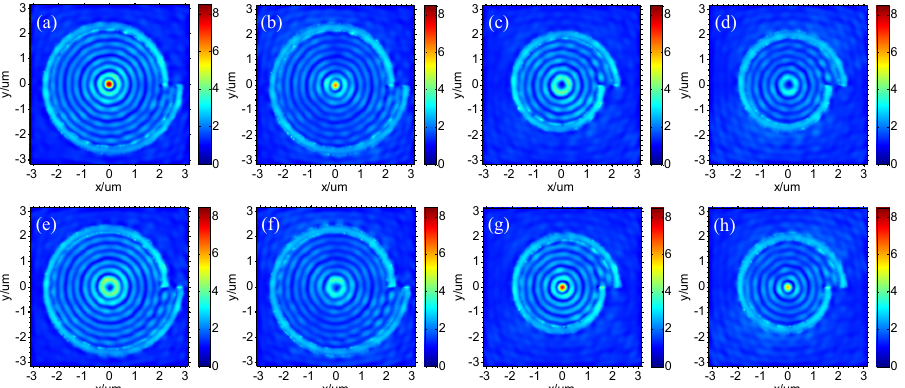
Figure 3. The electric field distribution |E| on the top surface of the plasmonic lens with different structures, illuminated by a circularly polarized beam ( λ = 633 nm ) with normal incidence from the top of the silver film, w 1 = 310 nm, w 2 = 155 nm, h 1 = 110 nm, h 2 = 45 nm, r 0 = 2000 nm. ( a ) |E| distribution when the spiraling of the slot parameter m = 1, with an auxiliary spiral slot and illuminated by a left-circularly polarized light. ( b ) is the same as ( a ) but for the structure without an auxiliary spiral slot. ( c ) is the same as ( a ) but for m = − 1. ( d ) is the same as ( c ) but for the structure without an auxiliary spiral slot. ( e–h ) are the same as ( a – d ), respectively, but for right-circularly polarized incident light.